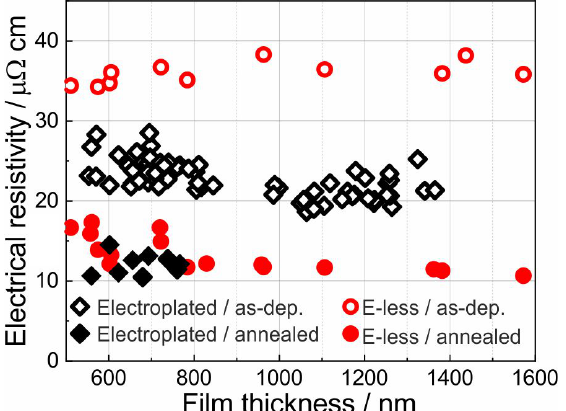
Figure 4. Electrical resistivity of electroless-deposited films in comparison with electroplated films for the as-prepared state and after annealing from room temperature up to 1000 ◦ C for 2